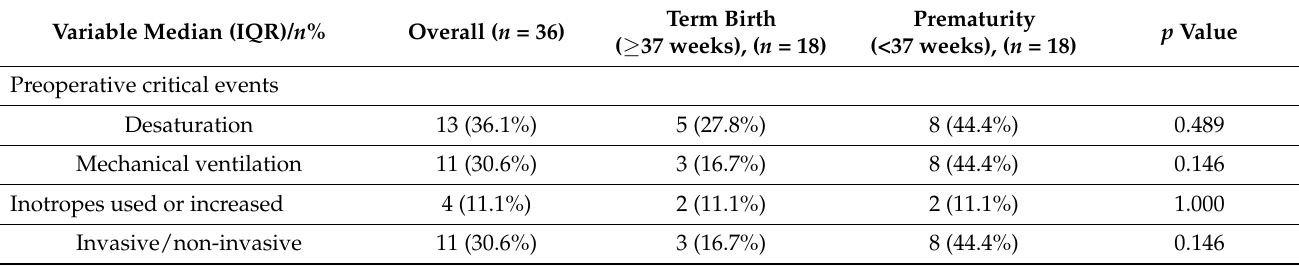
Table 4. Perioperative complications and outcomes between premature and term